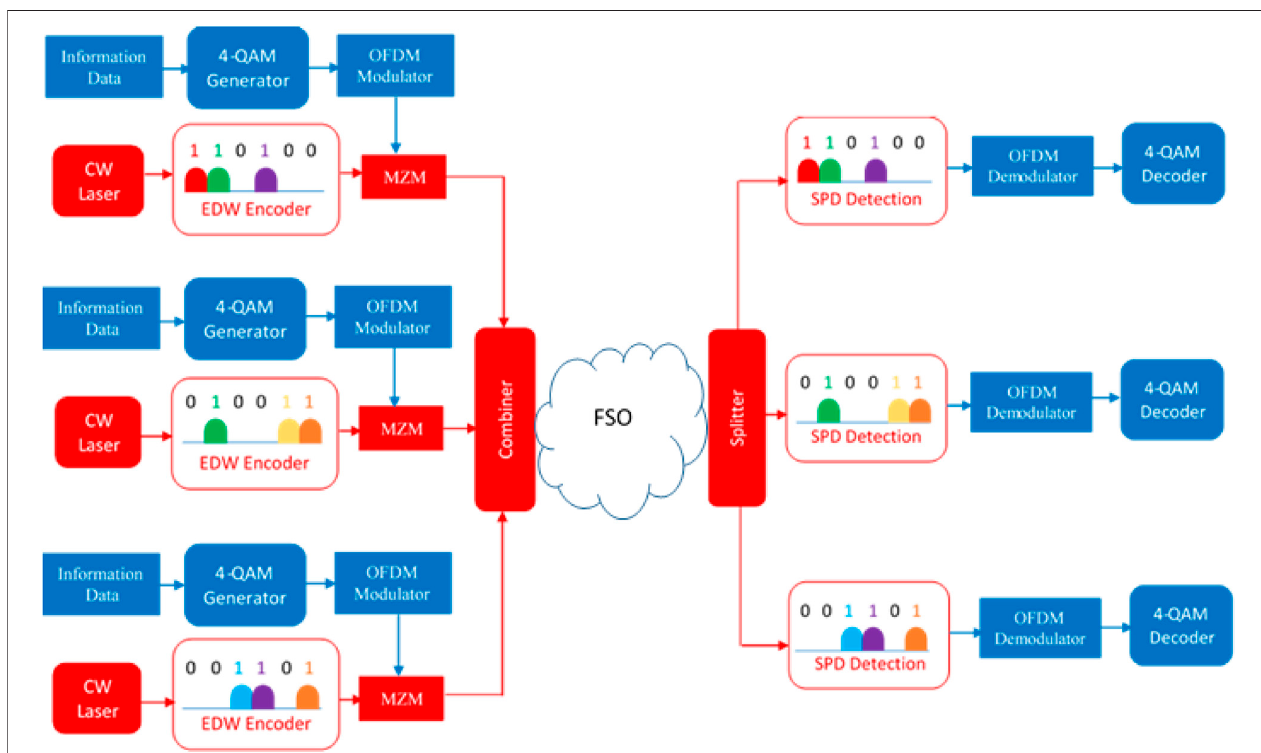
FIGURE 2 | Schematic diagram of the OFDM/SAC-OCDMA-based FSO